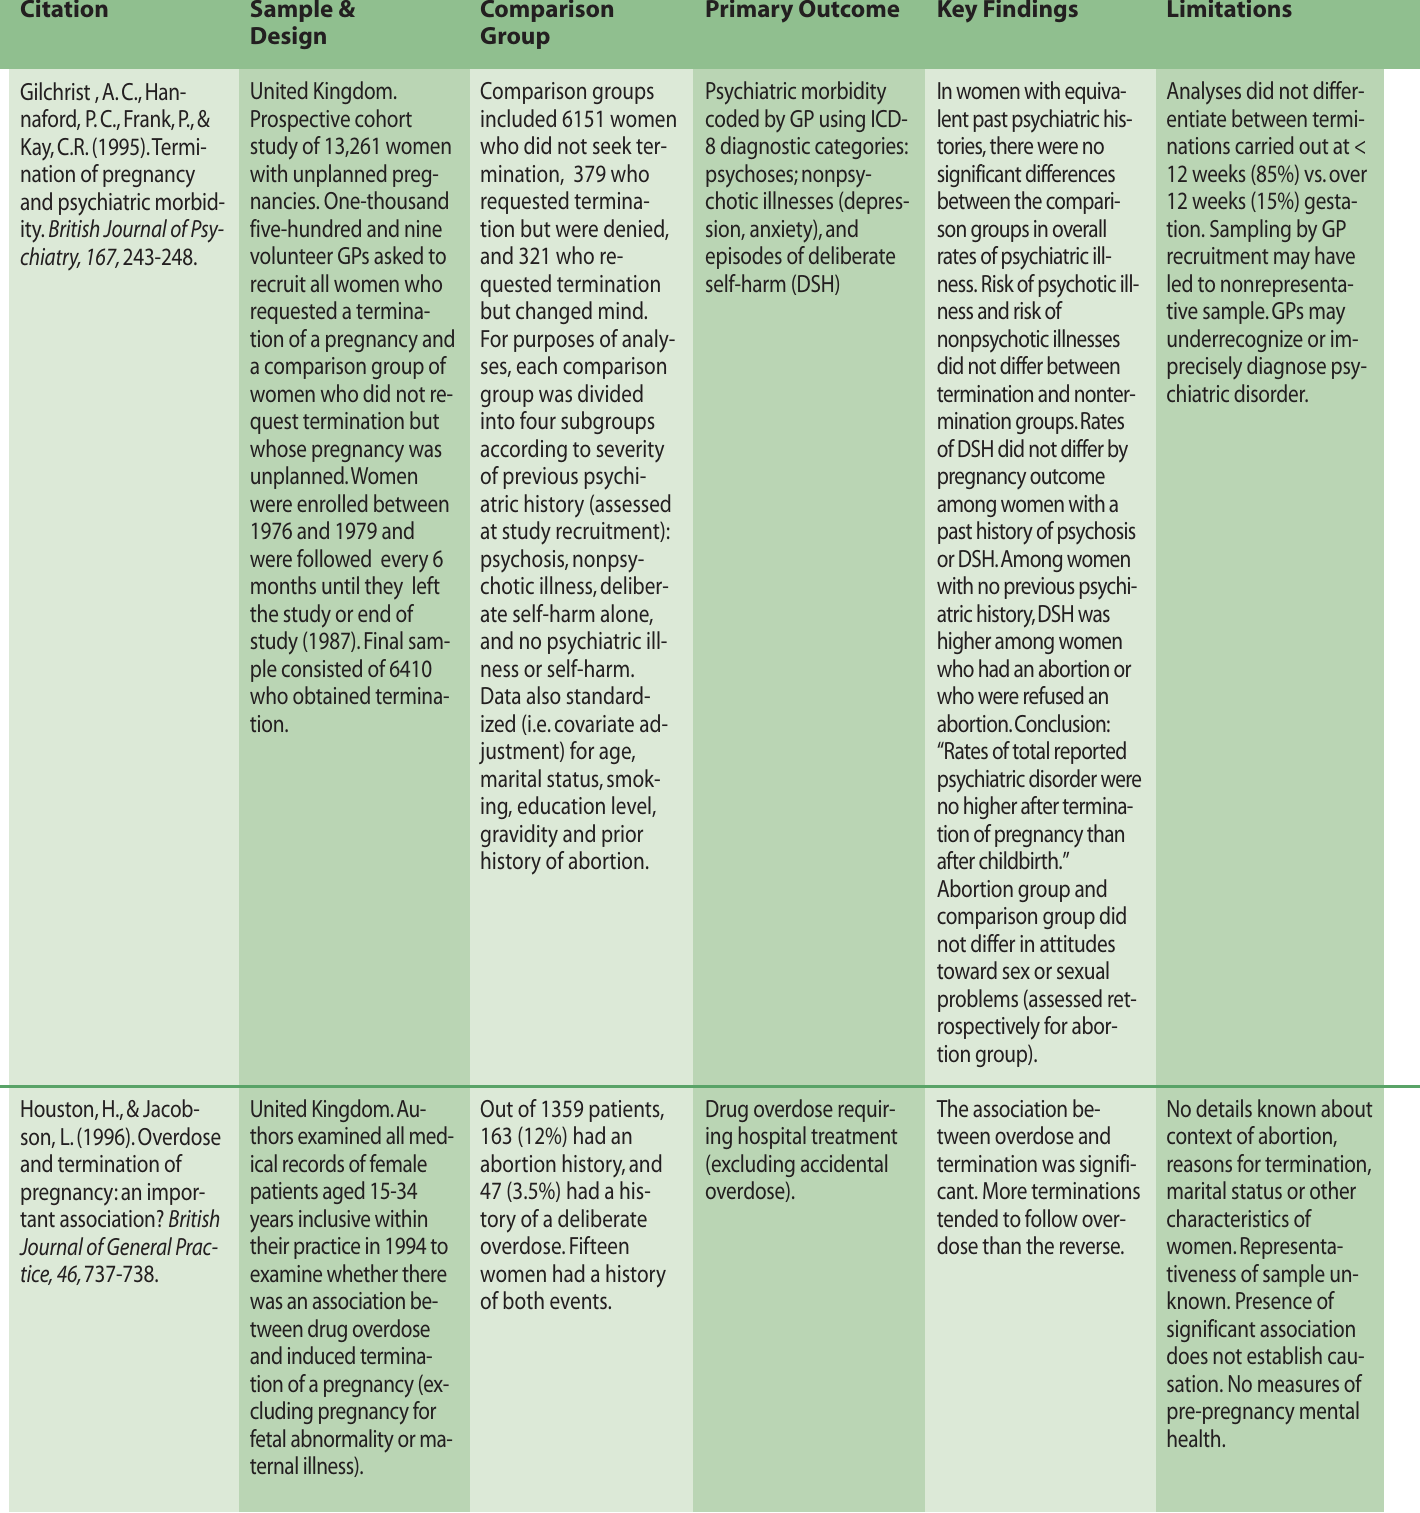
Table 3B: Comparison Group Studies